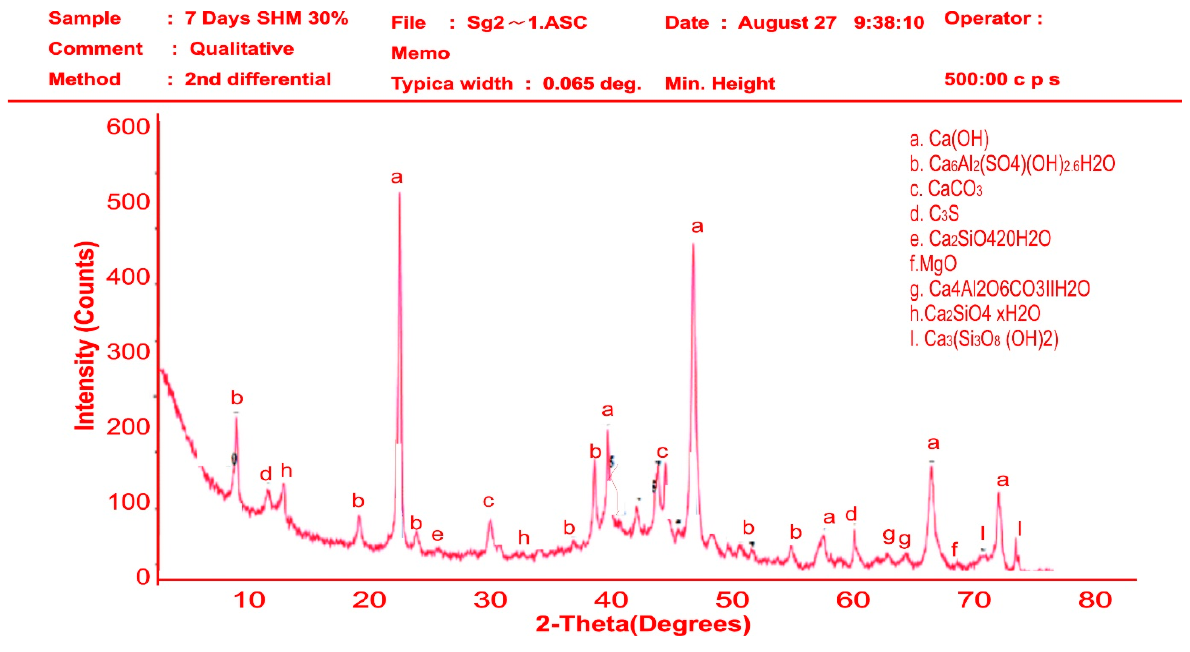
Figure 12. XRD pattern of the SPM-30 sample at 7 days.